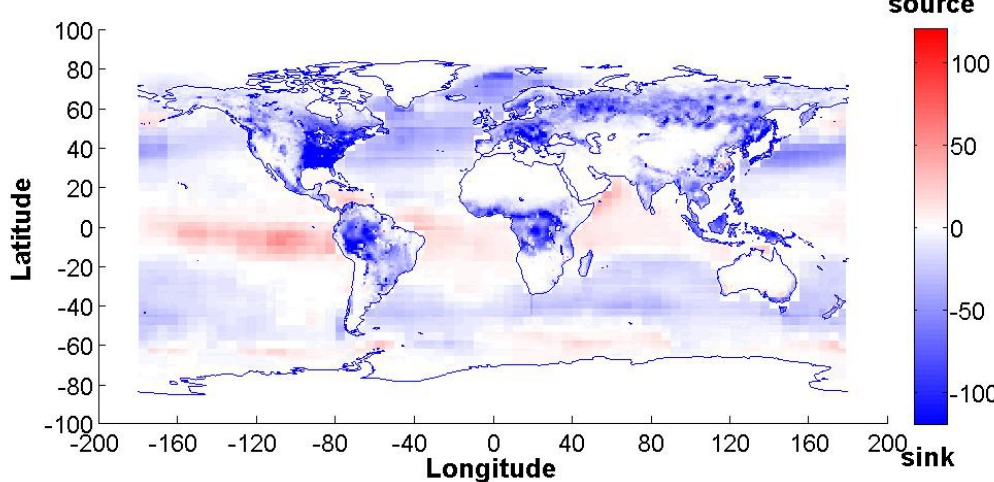
Figure 11. The average annual pattern of the optimized flux by GCAS-DOM for the years 2001–2007 (in g C m − 2 yr − 1 ).